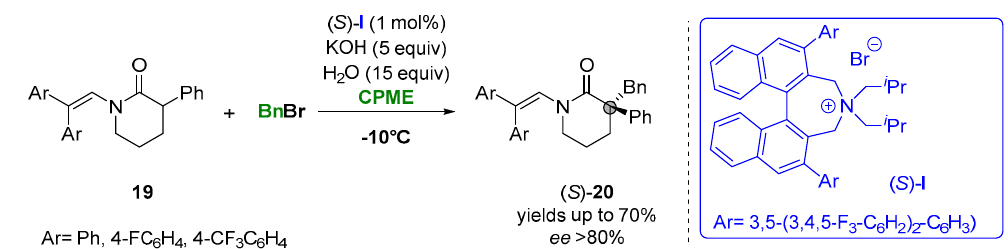
Figure 13. Asymmetric α -benzylation of six-membered lactams in CPME.